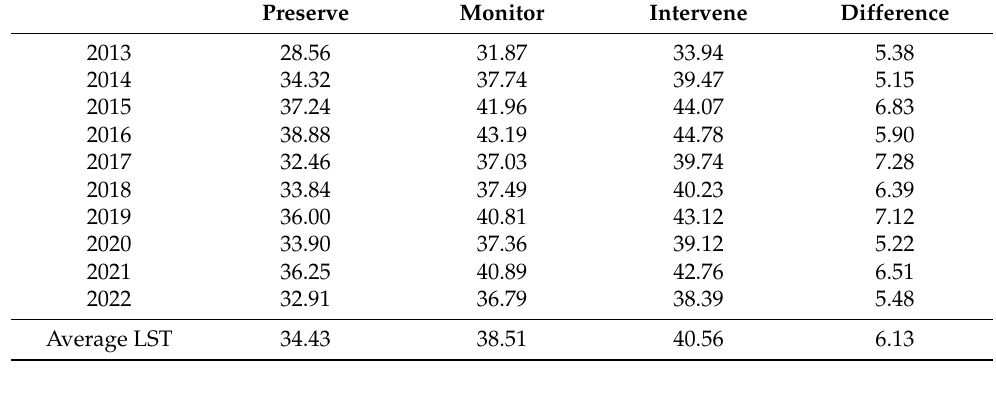
Table 19. Average LST ( ◦ C) per year per IUHI class of action.